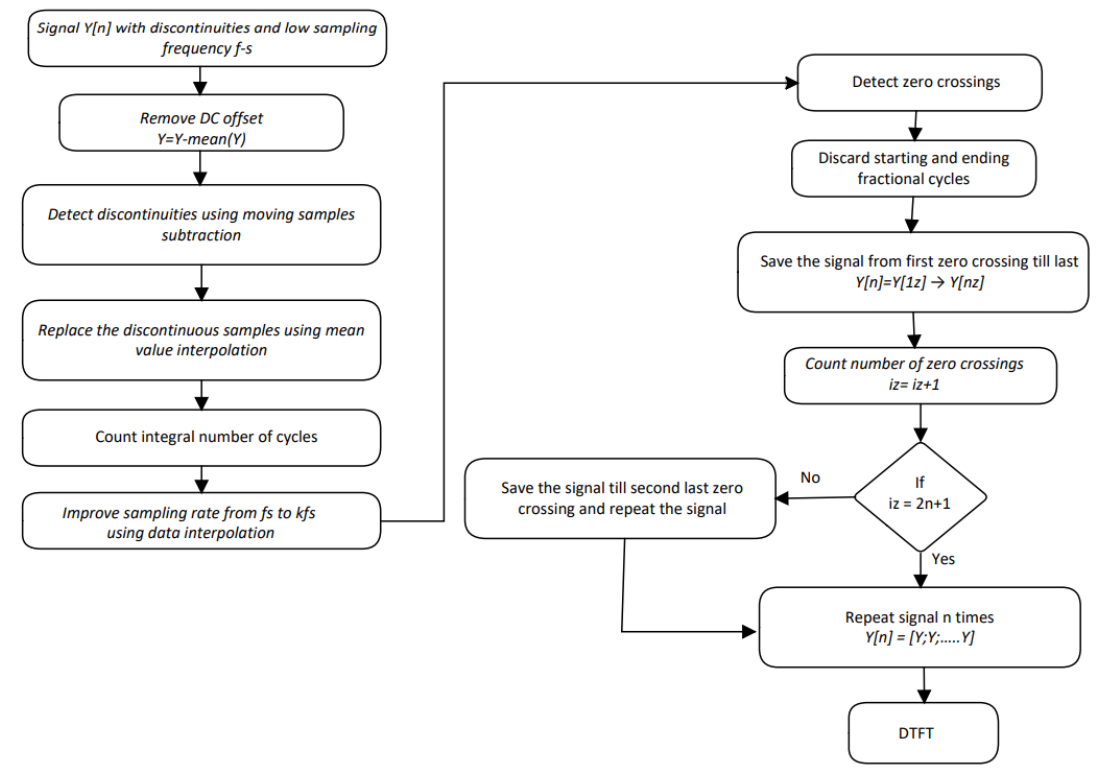
Figure 8. The algorithm for counting the integral number of cycles, removal of signal discontinuities and fractional parts of the signal, data interpolation, and repetition, if necessary.